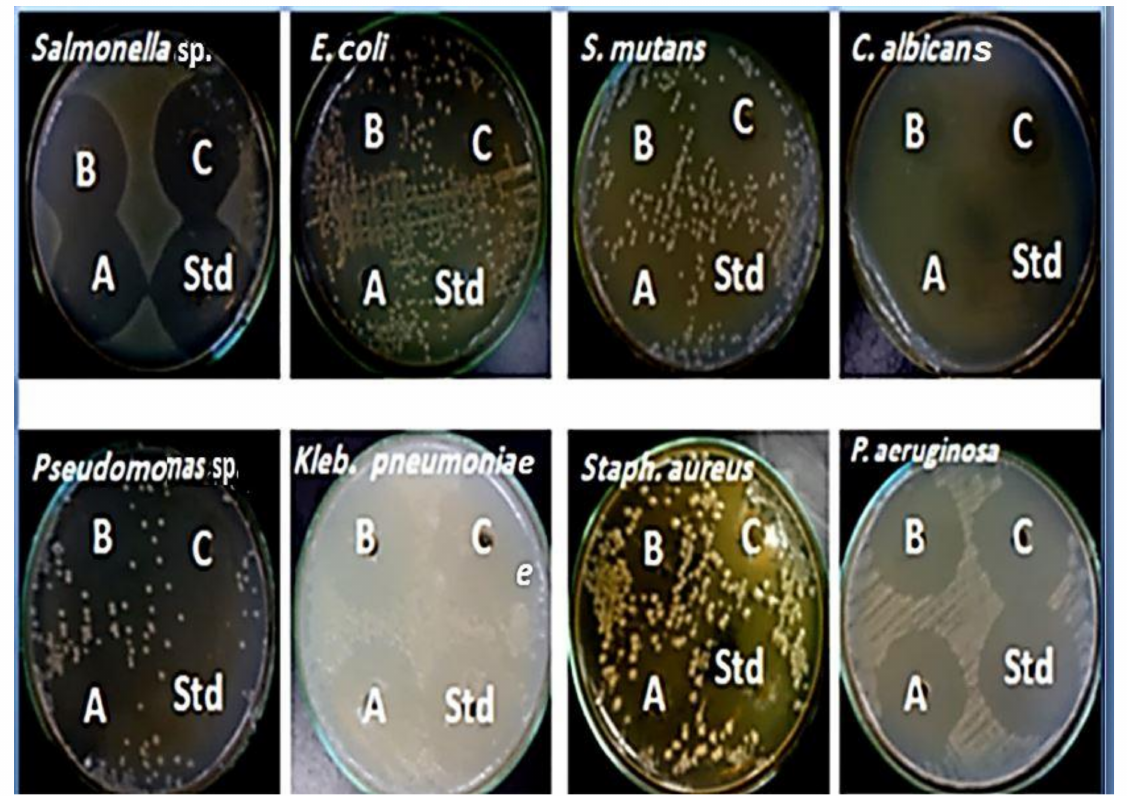
Figure 3. Antimicrobial activity of kefir grain powder: ( A ): 40 µ g/mL, ( B ): 50 µ g/mL and ( C ): 60 µ g/mL against selected pathogens compared with 10 µ g/mL ampicillin in term of a zone of inhibition (ZOI). Table 3. Antimicrobial activity of kefir grain powder 40 µ g/mL, 50 µ g/mL and 60 µ g/mL against